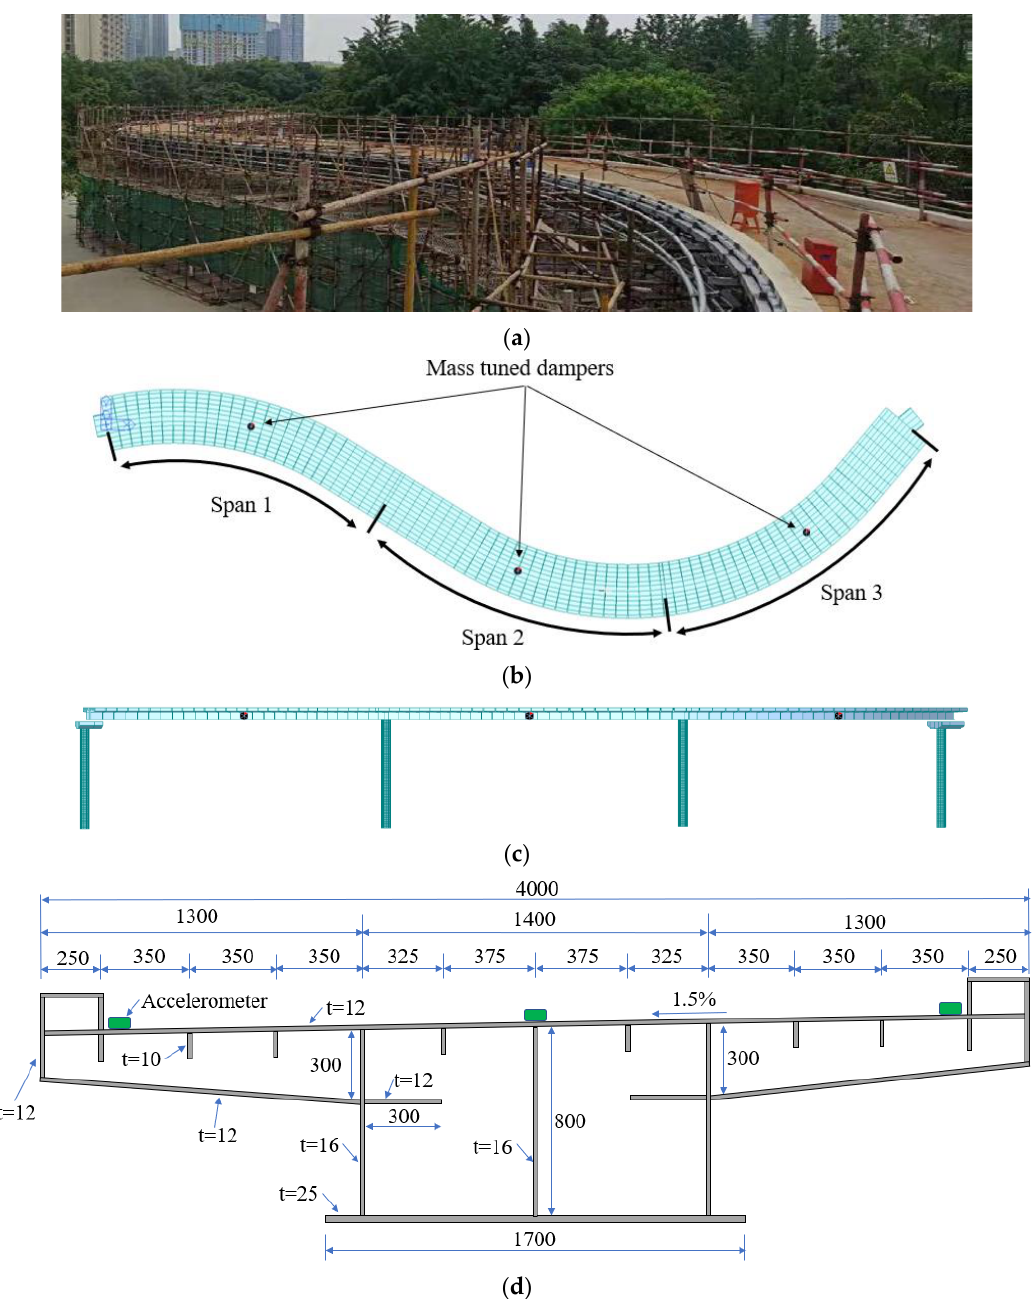
Figure 1. Illustration of the investigated bridge (unit: mm): ( a ) a photo; ( b ) the plan view; ( c ) the elevation view; and ( d ) the cross-section of the steel box girder.